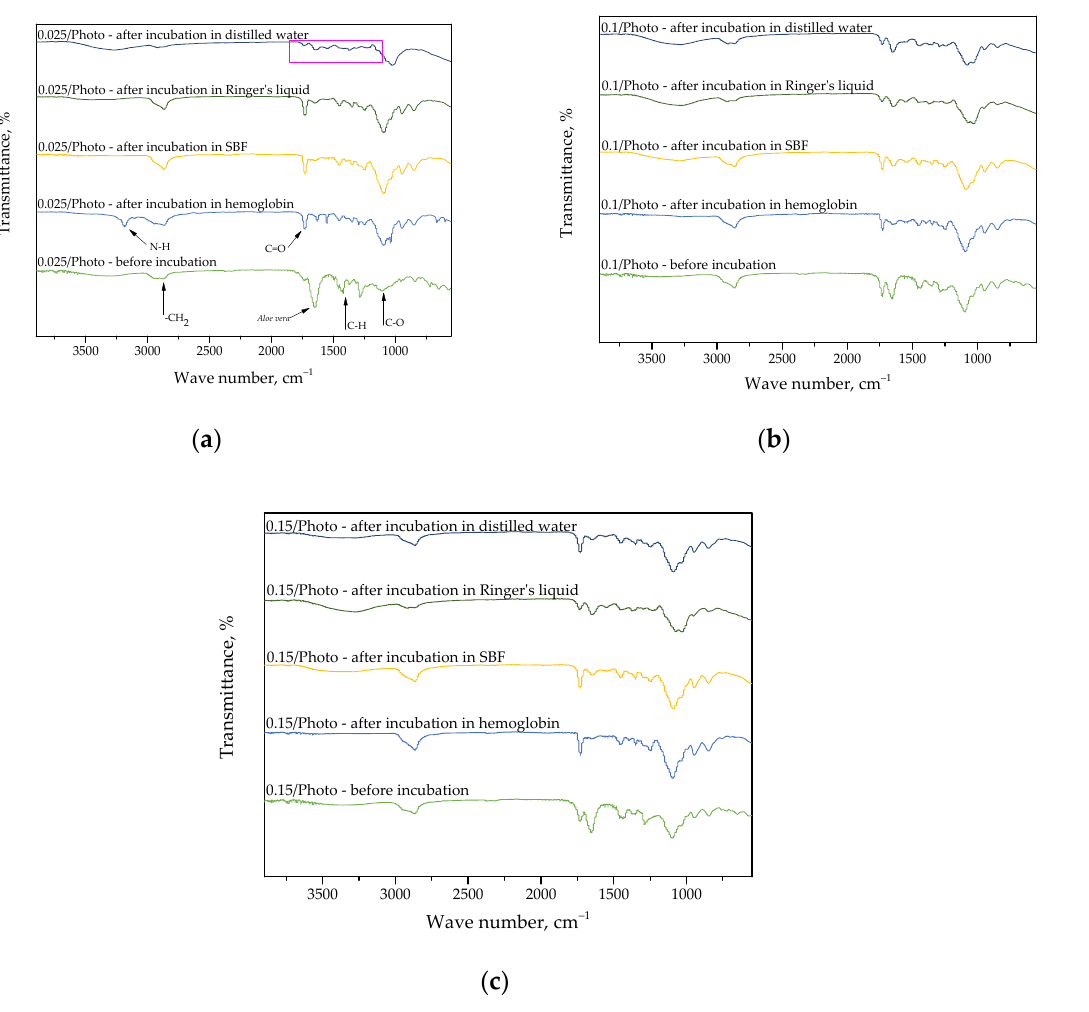
Figure 7. FT-IR spectra of sample 0.025/Photo ( a ); 0.100/Photo ( b ); and 0.150/Photo ( c ), before and after incubation. after incubation.